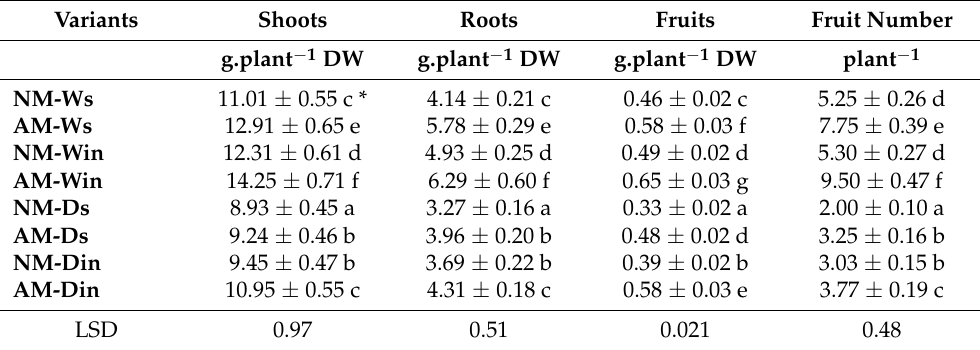
Table 1. Growth parameters of P. peruviana non-mycorrhizal ( NM ), AMF-inoculated (AM ), well- watered ( W ), drought-stressed ( D ), from seed-propagated ( s ), and in vitro propagated ( in ) plants. Variants Shoots